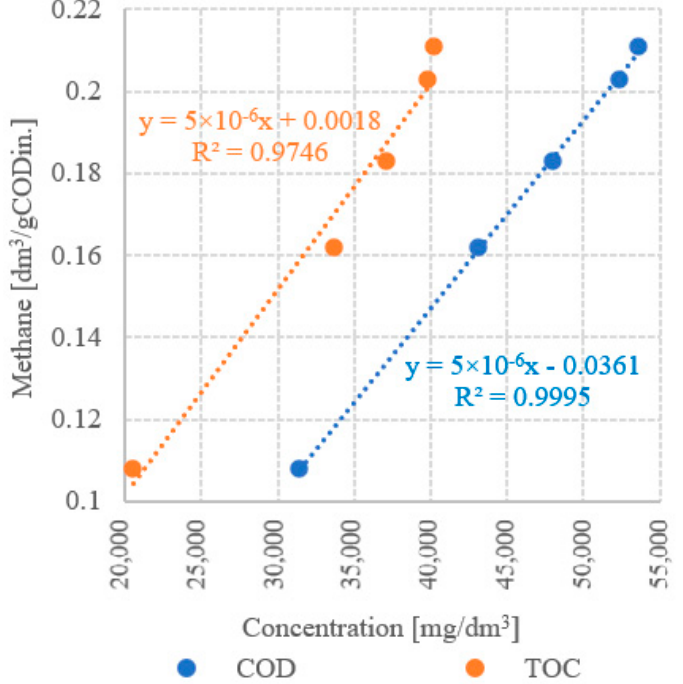
Figure 14. Correlation between concentration of dissolved organic compounds and CH 4 production.